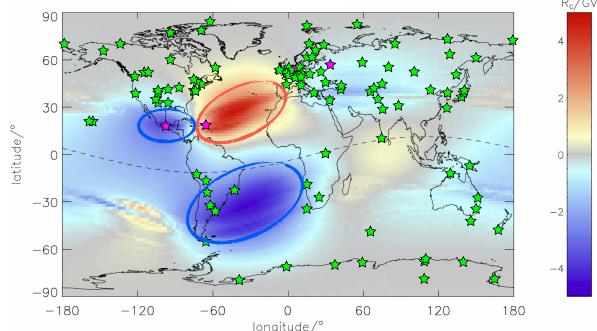
Fig. 5. Neutron monitor stations established between 1950 and 2012 (filled green stars). Colored in magenta are the stations used for our study: Kiel, Moscow, Mexico City and the hypothetical station at the British Virgin Islands